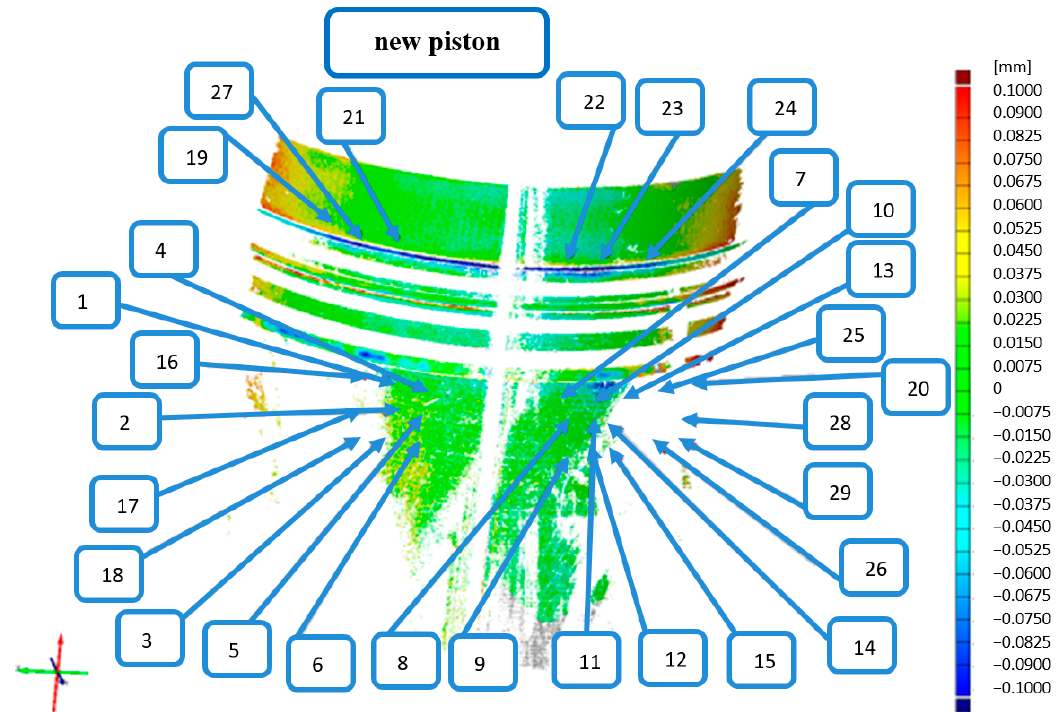
Figure 12. Geometrical deformation of the new piston at a temperature of 56 °C (Table 2). Table 2. Example results of the deformation of the new piston during the cooling process (NaN— data not available (deviations not determined) as a result of reflexes and thermal radiation leading to static disadvantages for optical measurement systems).